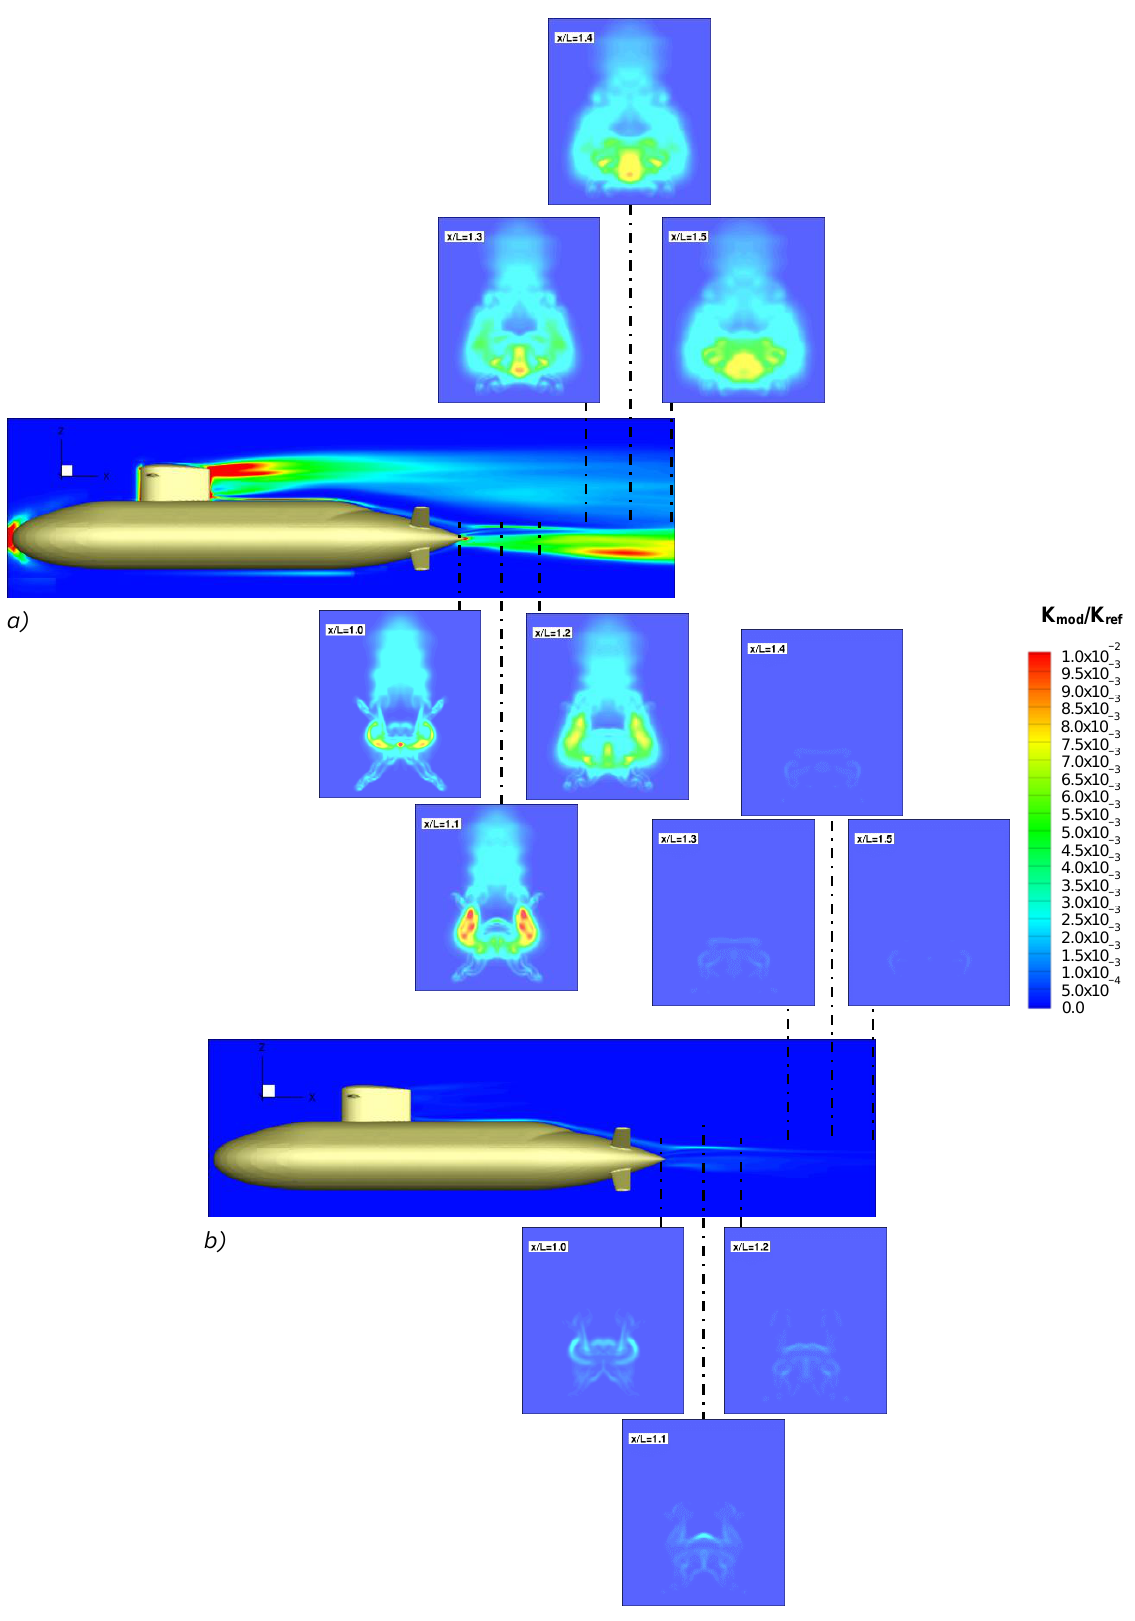
Figure 13. Resolved ( a ) and modeled ( b ) turbulent kinetic